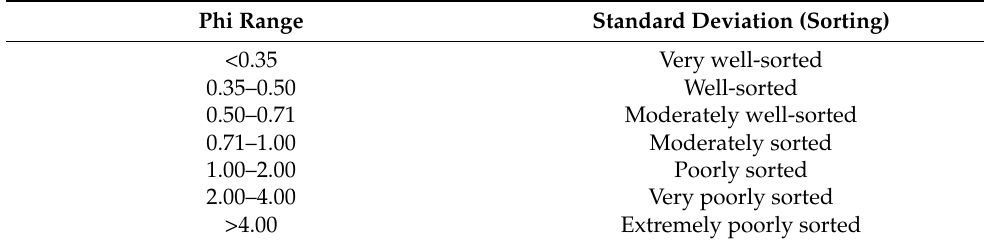
Table 5. Classification of sorting values, adapted from Roman-Sierra et al.